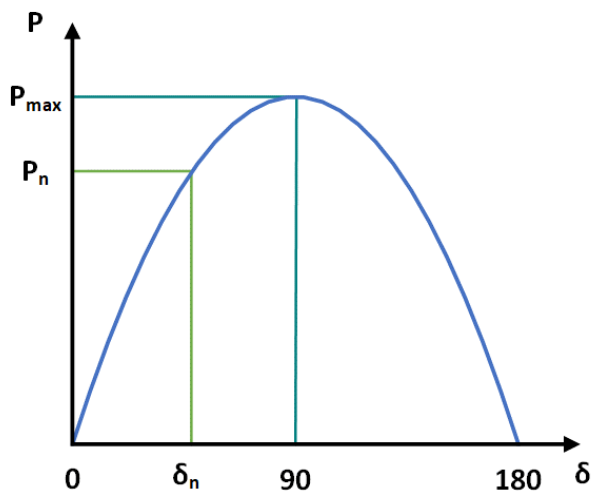
Figure 1. Load angle curve [11].